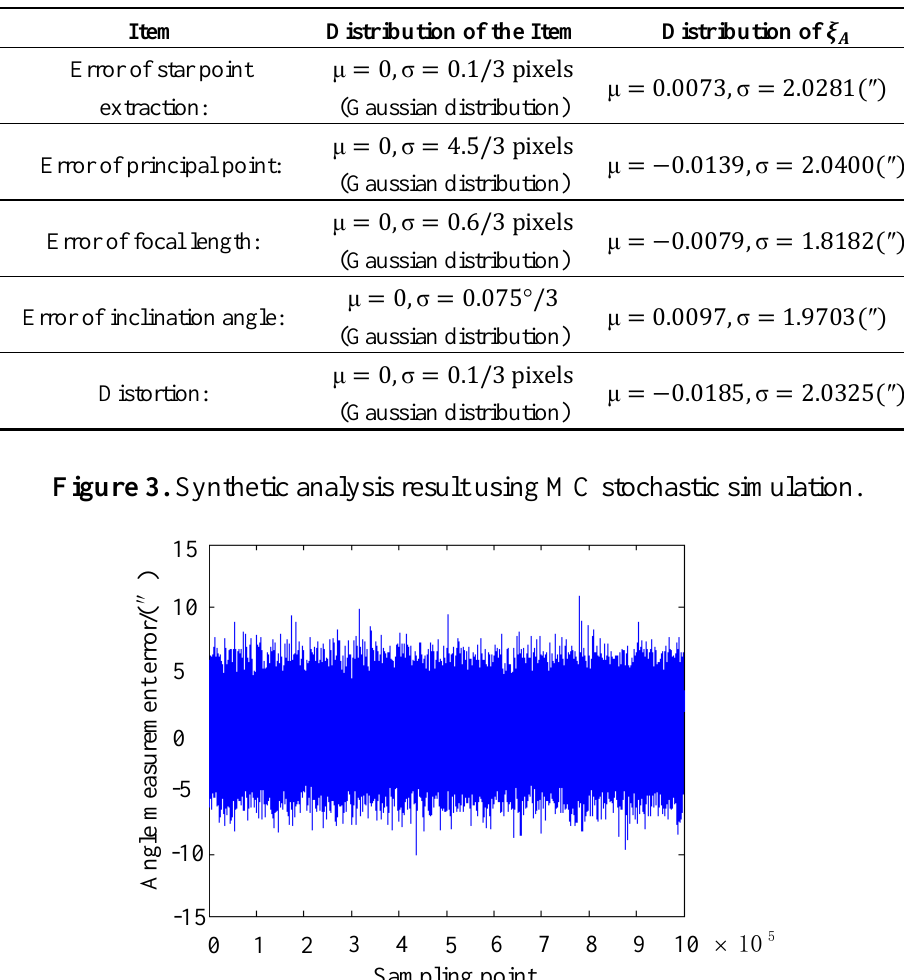
Table 1. Single-error factor analysis using MC stochastic simulation.